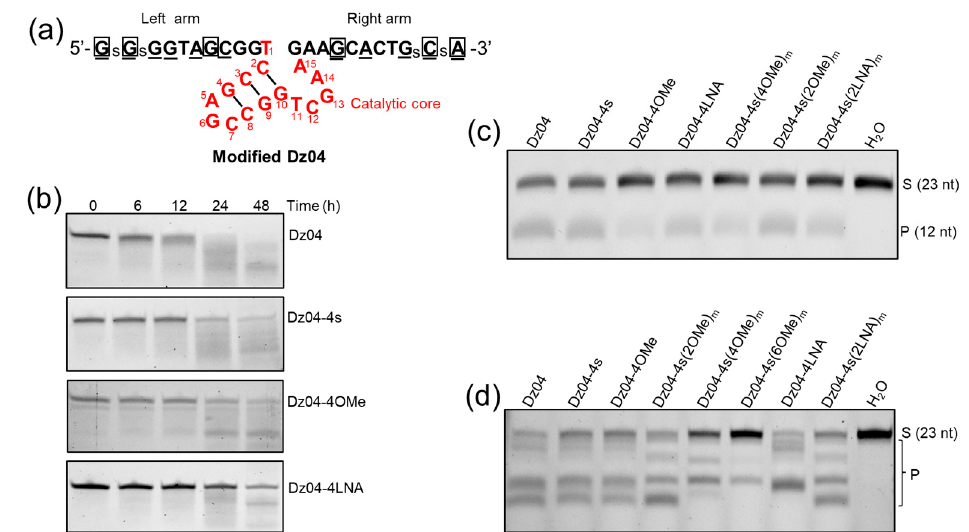
Figure 5. In vitro studies of stability, catalysis and RNase H compatibility of the DNAzymes with arm modifications. ( a ) Phosphorothioate linkage (PS), 2 ′ -O-methyl ribonucleotide (OMe), 2 ′ -O and 4 ′ -C LNA (LNA) are represented by “s”, “underlined” and “box” labels, respectively. ( b ) Stability study of the modified DNAzymes under FBS serum treatment. ( c ) In vitro cleavage study of the modified DNAzymes under physiological conditions. S: substrate; P: product. ( d ) Modified DNAzyme compatibility with RNase H.